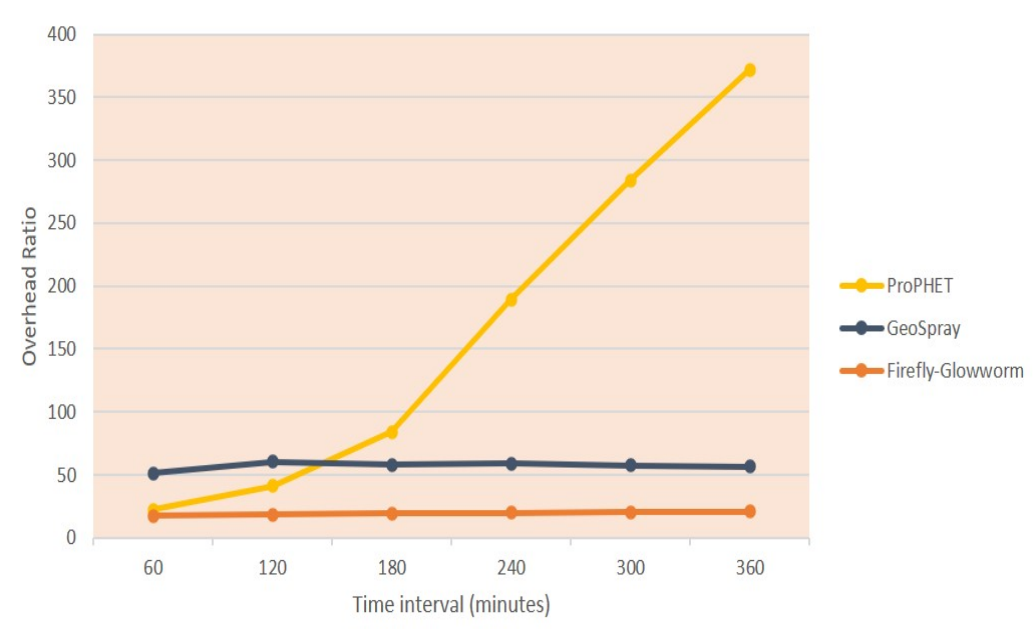
Figure 7. Number of Flooded Bundle Copies.